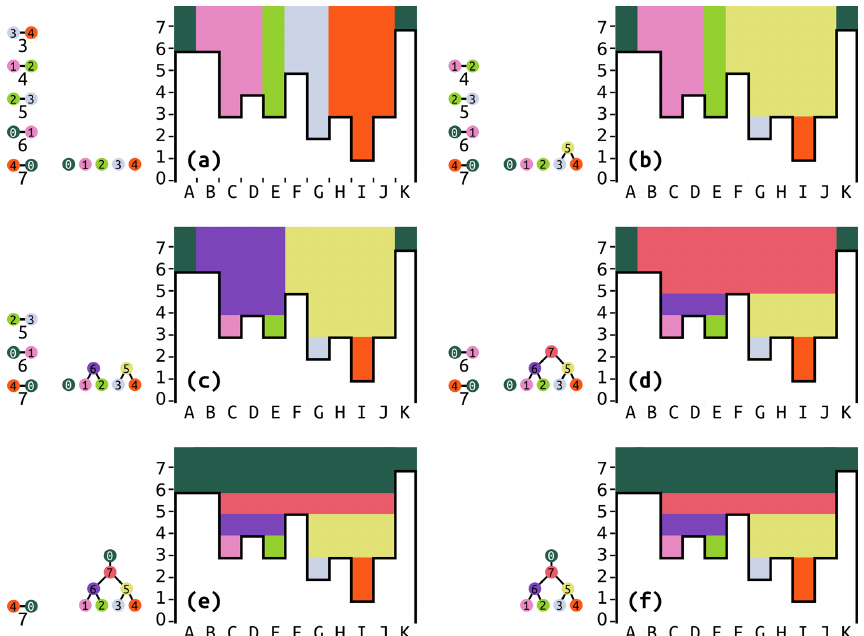
Figure 8. Illustration of the hierarchy construction. Boldface lowercase letters indicate progression through time. Capital letters label cells. The little barbells indicate outlets between depressions with numbers to indicate their elevations. The order of the outlets on the left represents the outlet positions (if any) in the priority queue (PQ). The tree that is progressively built represents the depression hierarchy. The black lines outlining the white regions indicate elevation, with values along the y axis. Colors represent labels, and the barbells on the left also indicate the depression number associated with each label color. (a) Initialization. This reflects the state at the end of Fig. 7. The five outlets have been sorted in order of increasing elevation. Five depressions are in the hierarchy, but none of them are connected yet. (b) The lowest outlet (between 3 and 4) is popped. A new meta-depression, labeled 5, is made and becomes the parent of 3 and 4. All cells in 3 and 4 with elevations equal to or greater than the outlet’s elevation implicitly become a part of 5. (c) The new lowest outlet (between 1 and 2) is popped. A new meta-depression, labeled 6, is made and becomes the parent of 1 and 2. All cells in 1 and 2 become part of 6. (d) The lowest outlet is now between 2 and 3. We note that 2 now has a parent and should actually be referred to as 6 (the disjoint set – DS – accelerates this lookup), while 3 also has a parent and should be referred to as 5. A new meta-depression, labeled 7, is created. (e) The lowest outlet is now between 0 and 1. We refer to 1 by its parent’s label, 7. 0 is the ocean, so no new meta-depression is made; 7’s parent simply becomes 0. (f) The outlet between 4 and 0 is the only one left. But 4’s parent is already 0, so nothing needs to be